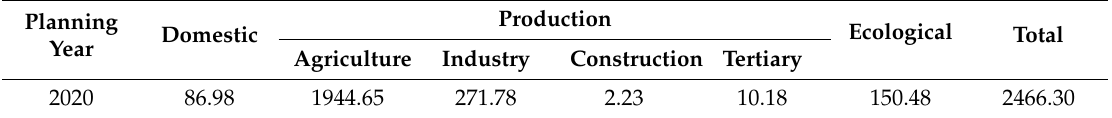
Table 6. Forecasted water demand for the Shiyang River Basin in 2020 (million m 3 ). Planning